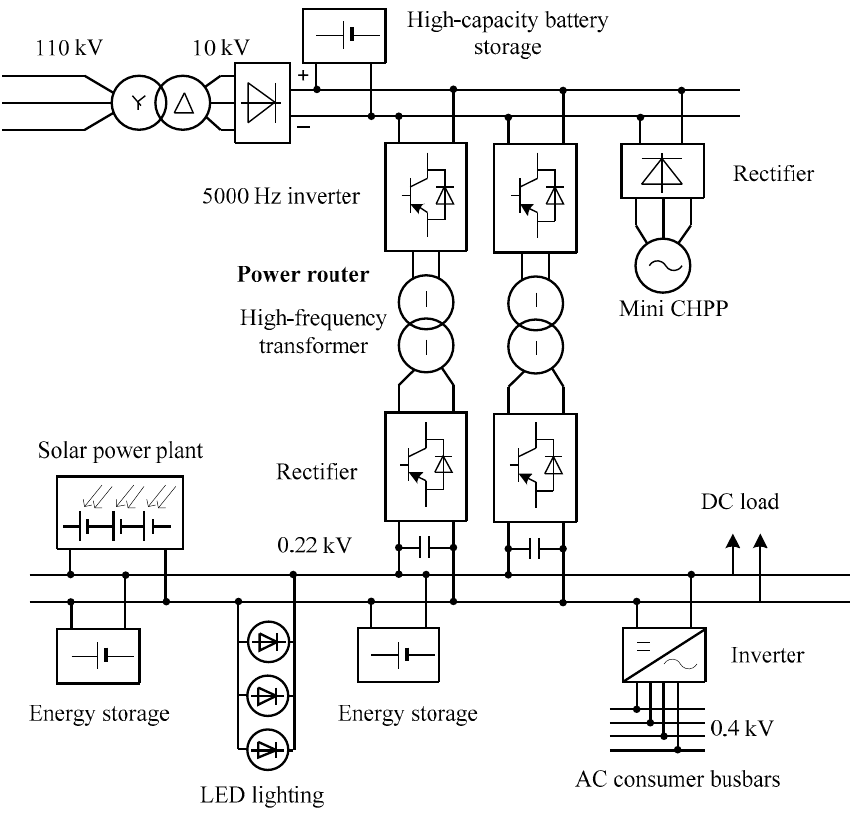
Energies 2023 , 16 , x FOR PEER REVIEW Figure 4. Diagram of the investigated power router-based DC grid. Figure 4. Diagram of the investigated power router-based DC grid.